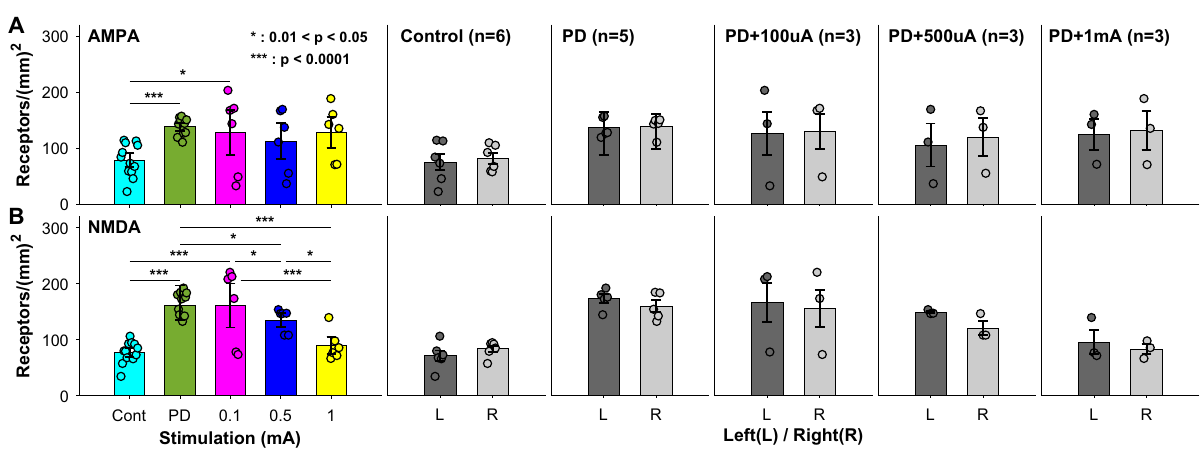
Figure 6. Populational distribution of AMPA ( A ) and NMDA glutamate receptors ( B ) depending on the electrical charges by GVS. Each column presents a total population of controls, PD, PD with 100, 500, and 1000 μA), and their comparisons between left (L) and right (R) are shown with no significance ( p > 0.721 in AMPA & p > 0.096 in NMDA receptor). Both receptors increased significantly after the construction of PD model ( p = 1.33 × 10 −5 in AMPA & p = 1.85 × 10 −9 in NMDA receptor). Increased electrical charge has